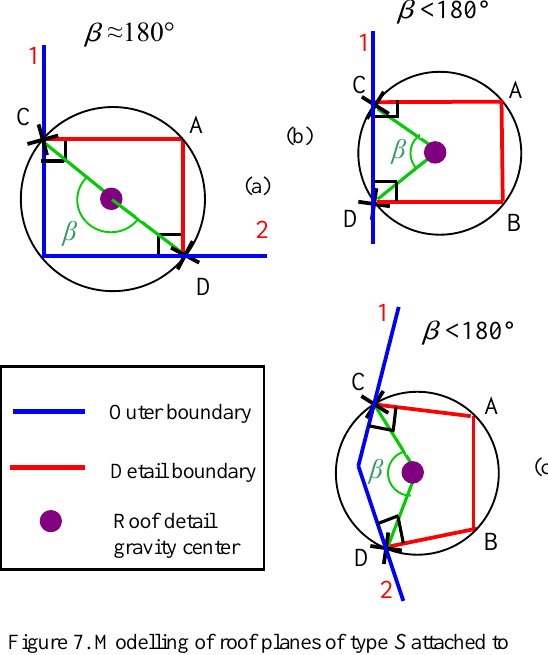
Figure 7. Modelling of roof planes of type S attached to building outer boundaries; a) Plane attached to two outer boundaries; b) Plane attached to a single outer boundary; b) Plane attached to two outer boundaries but it is treated as the case of Figure 7b